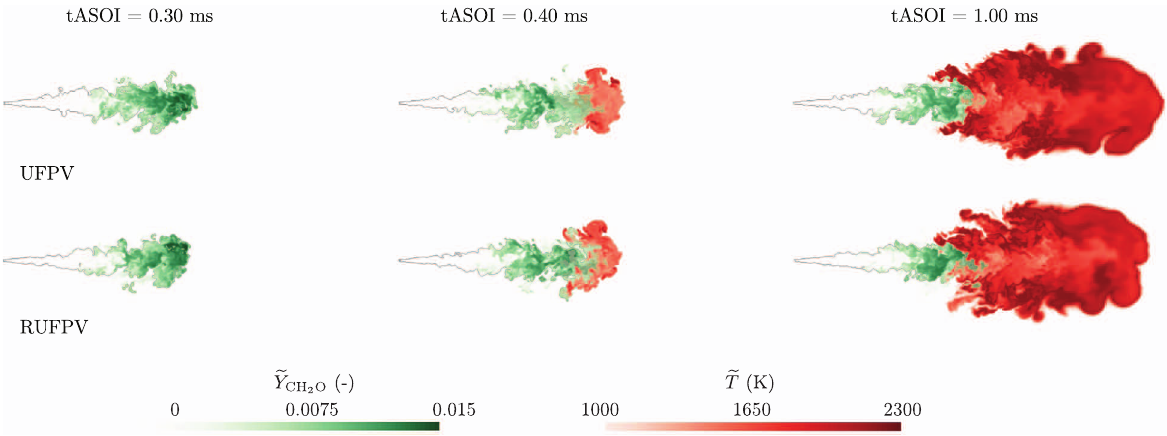
Fig. 13. Distribution of the CH 2 O mass fraction ~ Y CH and the temperature ~ T obtained using the original UFPV approach (top row) 2 O and the RUFPV approach (bottom row) for 0.30 ms (left column), 0.40 ms (middle column) and 1.00 ms ASOI (right column). The ~ Z ¼ ~ Z iso-line of st is shown as